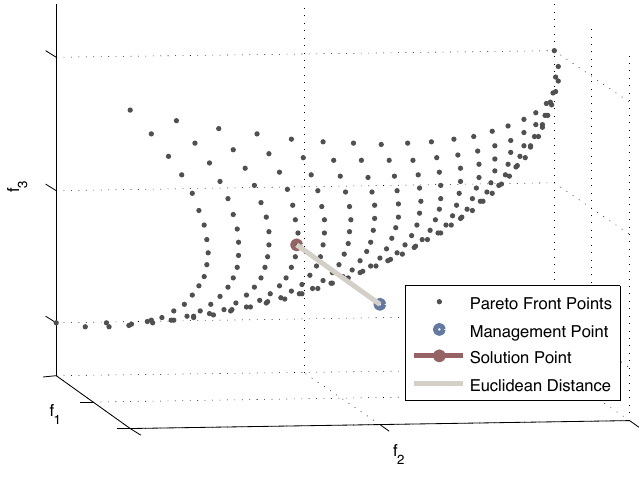
Figure 1. DM strategy graphically